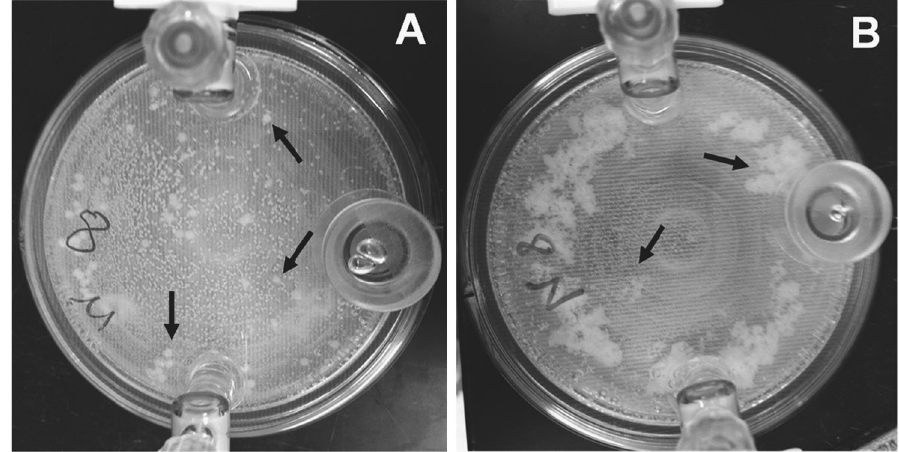
Fig. 2 Representative S. mutans end-point HARV cultures grown for 8 h in bio fi lm media under simulated microgravity ( a ) and normal gravity ( b ) conditions. Note the structural differences of the self-aggregating bacterial cells under each condition (indicated by arrows